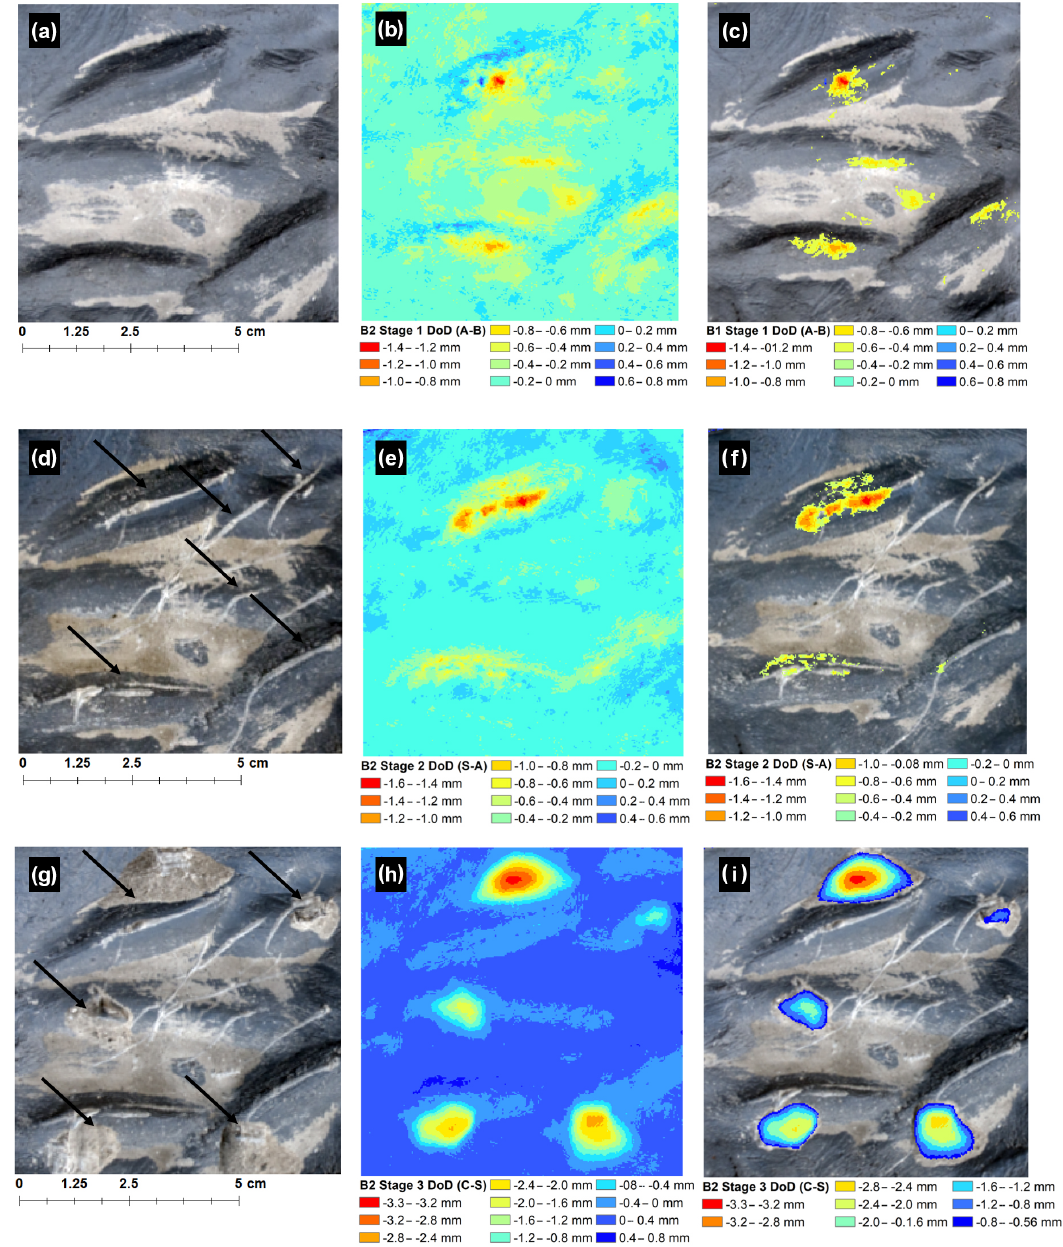
Figure 5. (a) B2 Stage 1 orthophoto showing abraded area (light grey) of simulated platform surface, (b) B2 Stage 1 DoD before thresholding at LoD, and the thresholded DoD (c) . (d) B2 Stage 2 orthophoto showing scratched surface of B2 (black arrows). (e) B2 Stage 2 DoD